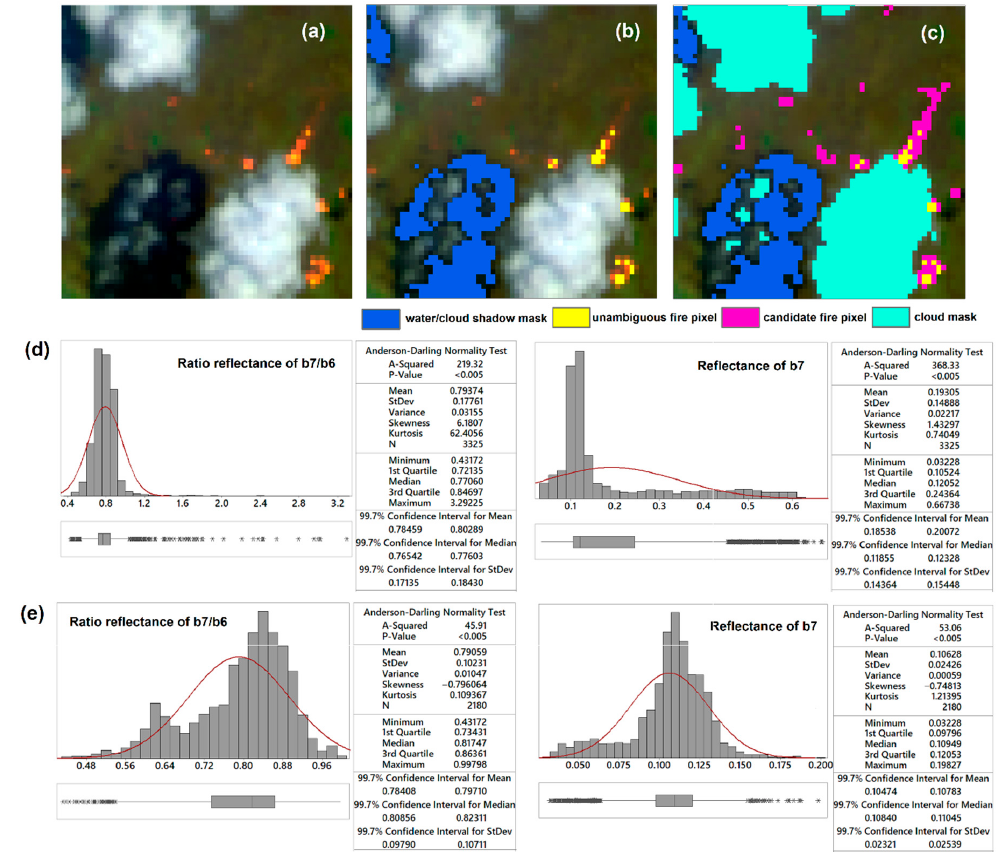
Figure 7. ( a ) Example of 764 Red-Green-Blue (RGB) image of Landsat-8 on 28 September 2018 and a 61 × 61 pixel window size with some fire features (in yellow to oranges tones) and background pixels with dominant objects, e.g., cloud (white), cloud shadow (black), soil/open land (brown), and vegetation (green); ( b ) The same RGB image as ( a ) overlaid with water/cloud shadow mask (blue) and obvious fire pixels (yellow) as per-previous studies [37,38,40]; saturated flaming pixels and permanent bright objects did not exist in this sample; ( c ) The same with ( b ) but with additional masks for cloud (light green) and candidate fire pixels (pink); ( d ) The histogram and population statistics of the ratio reflectance band-7 ( (cid:2025) (cid:2870).(cid:2870) ) to band-6 ( (cid:2025) (cid:2869).(cid:2874) ) and reflectance of band-7 of background pixels which excluded water/cloud shadow and unambiguous fire pixels as shown spatially in ( b ); ( e ) The histogram and population statistics of the same variable with ( d ) but with additional masks of cloud